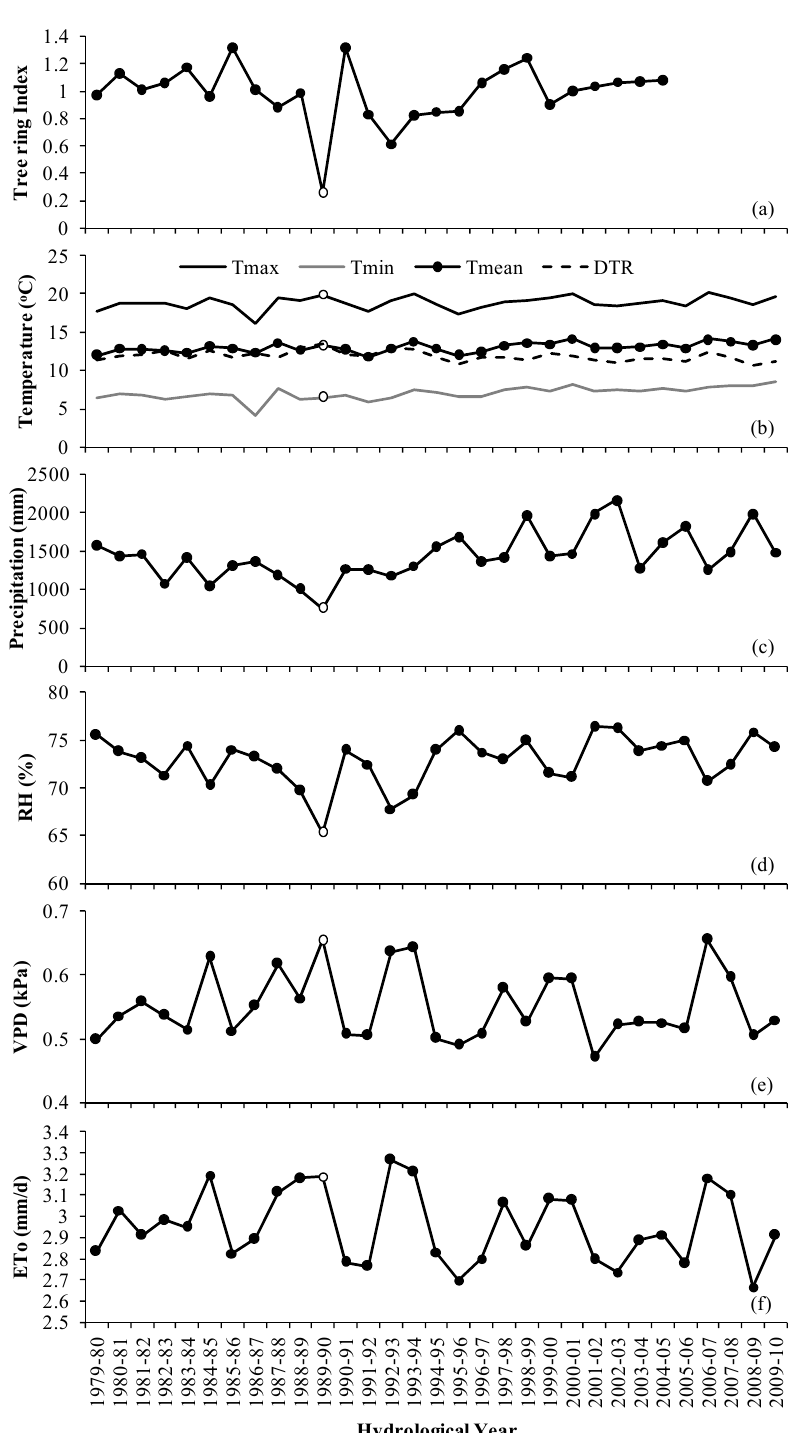
Figure 3. Interannual changes of ( a ) TRWI, ( b ) T min , T mean , T max and diurnal temperature range (DTR), ( c ) precipitation, ( d ) RH, ( e ) VPD and ( f ) ETo for the hydrological years from 1979–1980 to 2009–2010.